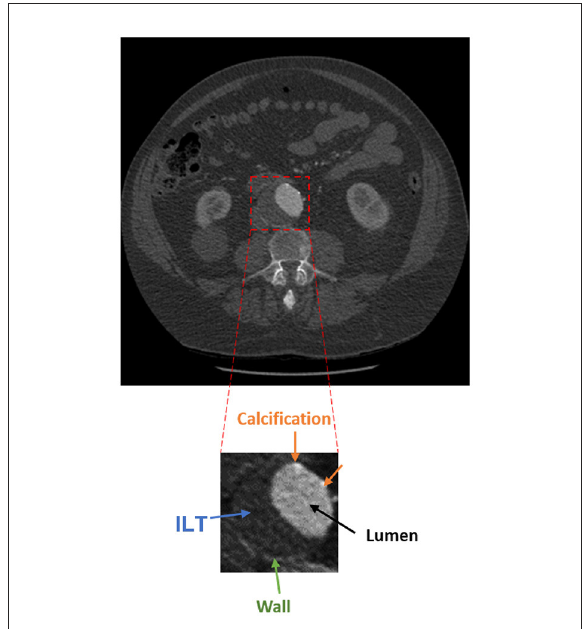
FIGURE1 Axial acquisition of an abdominal CT scan showing an AAA. The aorta is a small fraction of the whole image and is composed of the lumen (black), ILT (blue), wall (green), and calcification